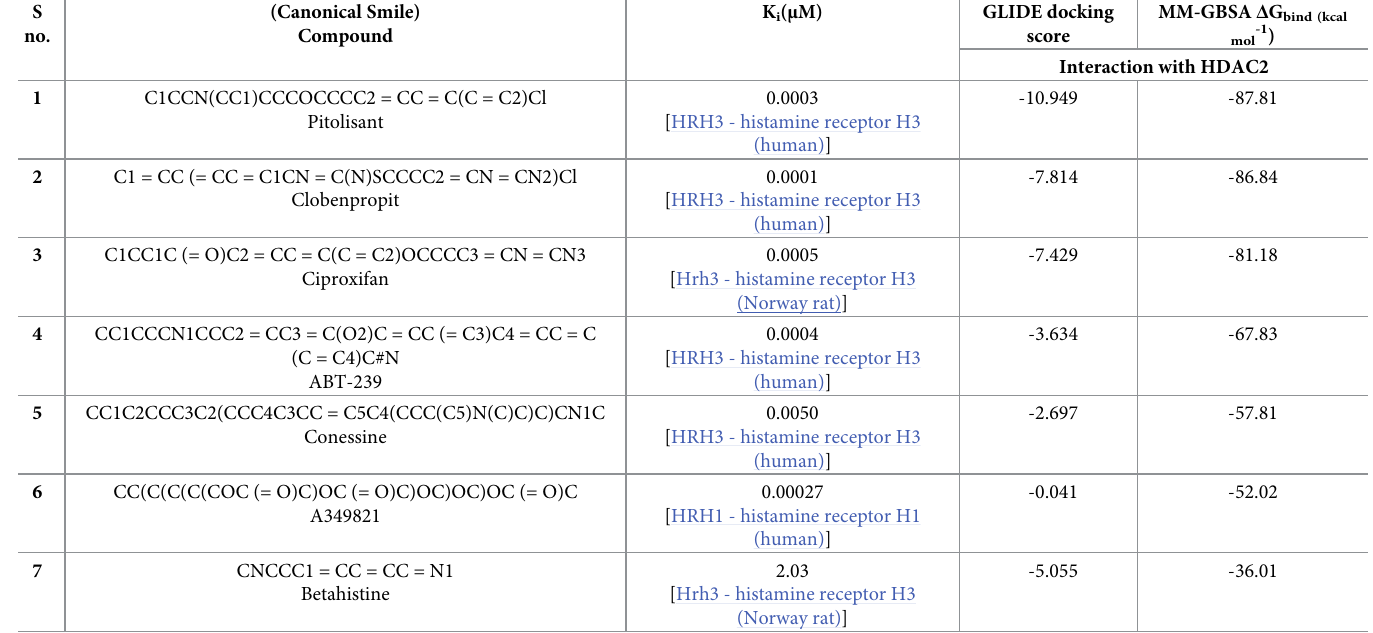
Table 1. Binding profile of experimentally validated H3R inhibitors against HDAC2 active